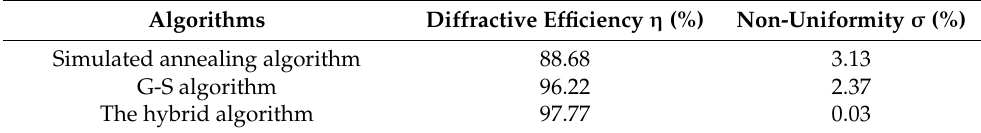
Table 2. The comparison of the design results of three algorithms.